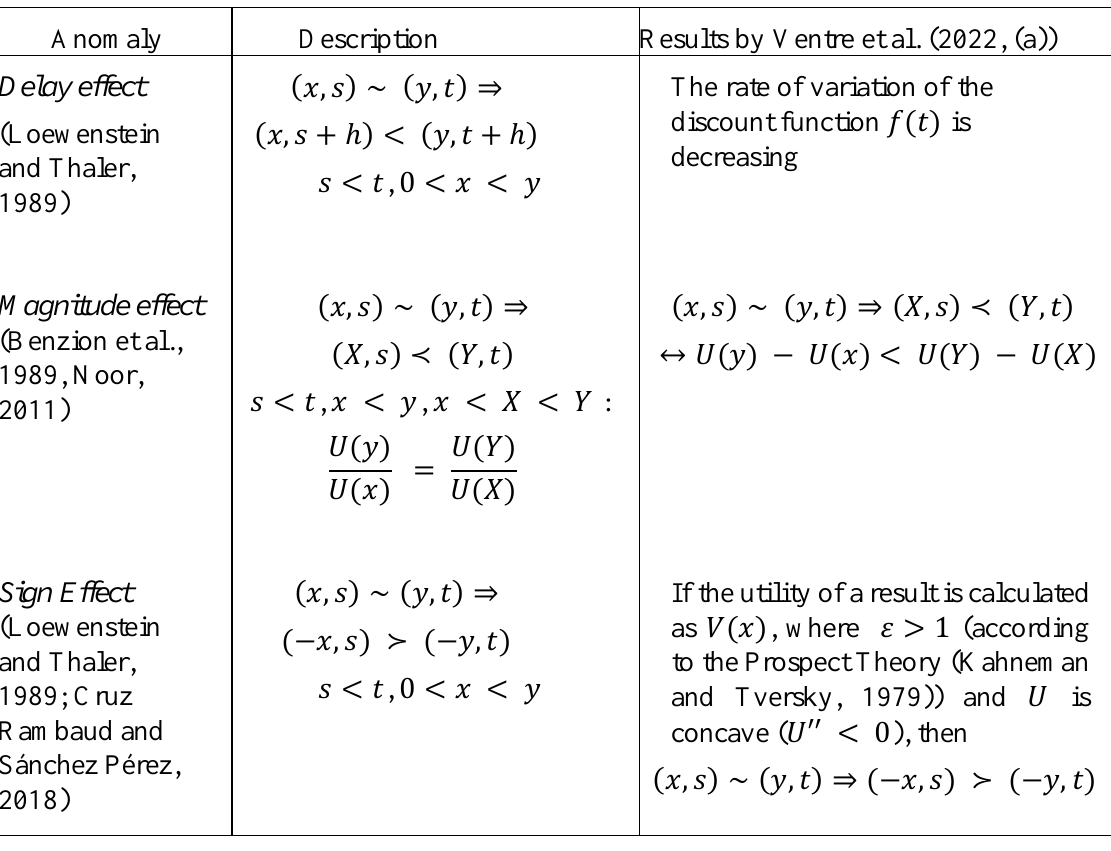
Table 1: Some results by Ventre et al. (2022, (a)).